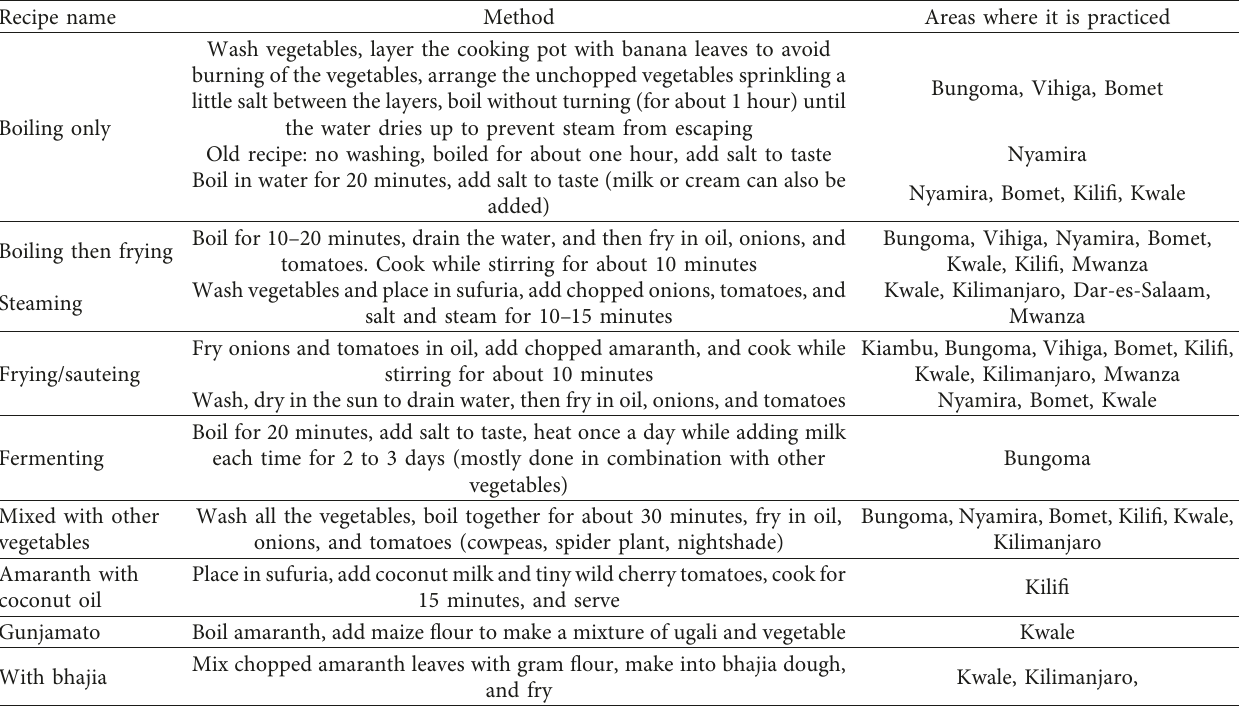
Table 2: Common amaranth cooking methods in Kenya and Tanzania. Recipe